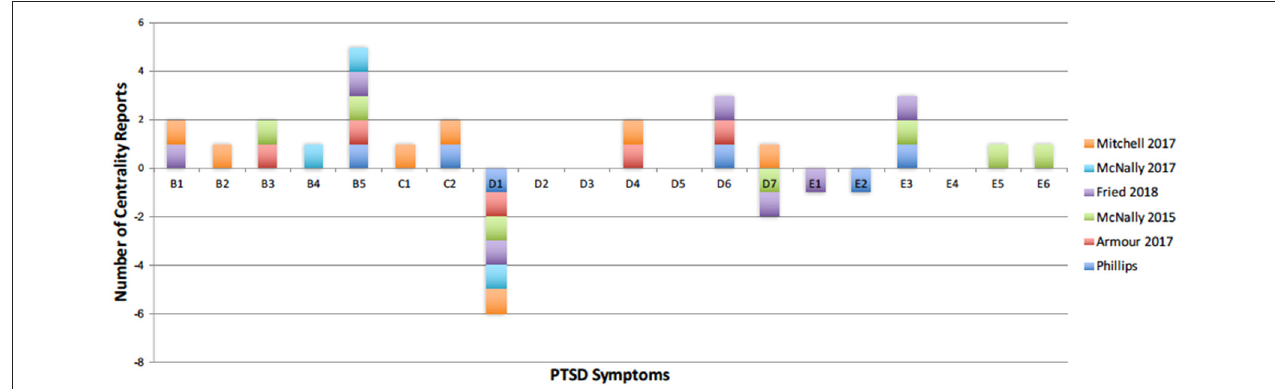
FIGURE 5 | PTSD symptoms that have been reported as central in recent literature. Positive number of reports represent the most central symptoms, and negative number of reports illustrate symptoms with low centrality. Current centrality results are shown in dark blue. Reports are low for symptoms D2, D3, and D4 because these are recent additions to the DSM-5 criteria of